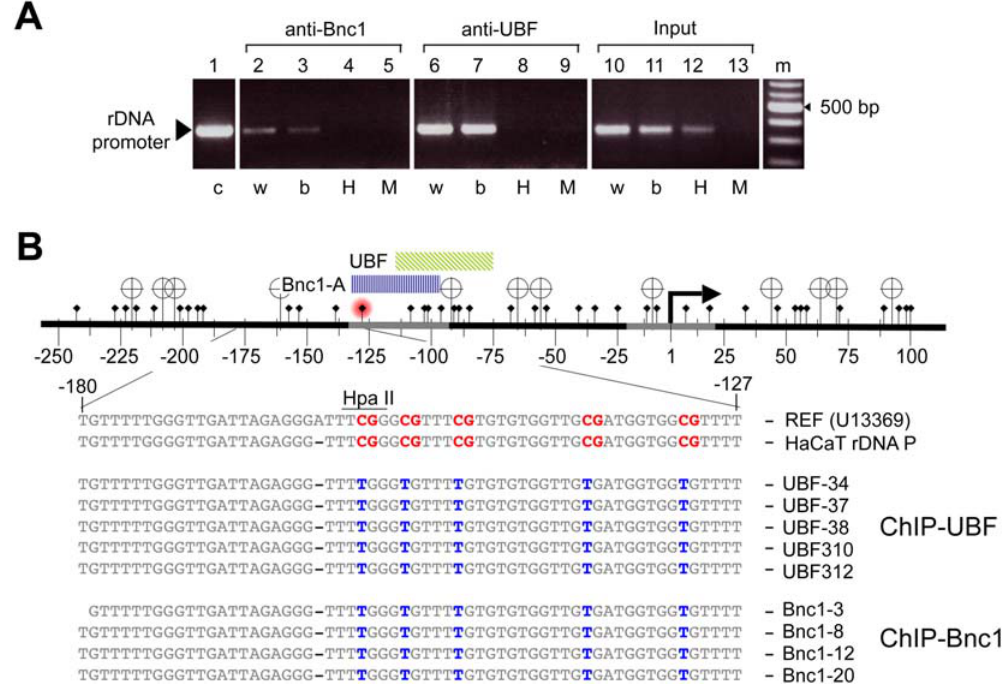
Figure 4. Basonuclin-associated rDNA promoter is hypomethylated. The DNA methylation status of basonuclin-associated rDNA promoter was analyzed by the HpaII/MspI sensitivity assay ( A ) and by bisulfite sequencing ( B ). A , A PCR analysis of the integrity of the rDNA promoter after HpaII or MspI digestion. The source of PCR templates is indicated above the gel image, and the treatment received by the templates, below. c, control template (genomic DNA), w, templates were incubated in water, b, in restriction buffer, H, with HpaII, M, with MspI. B , Depicted on top is the region of rDNA amplified by the PCR shown in A . Transcription start site is indicated as a bent arrow and the cis-elements are depicted as gray segments. HpaII/MspI sites are shown as banners and CpG sites, diamond-headed pins. Cytosine at position 2 132 is marked with a red hallo. The regions of basonuclin and UBF DNase I footprints are indicated by color-coded bars above the DNA. Listed below are DNA sequences from the region in between 2 180 to 2 126. The reference (U13369) and HaCaT rDNA promoter consensus sequences (the first two lines, respectively) are shown as they are sequenced after bisulfite treatment; i.e., all CpGs (in red) are assumed to be methylated and the rest of the Cs are converted to Ts due to the bisulfite treatment. The rest nine sequences are actual bisulfite sequencing data from five UBF-associated promoters and four basonuclin-associated promoters. The presence of a T (in blue) in the CpG position signifies that the CpG was not methylated.